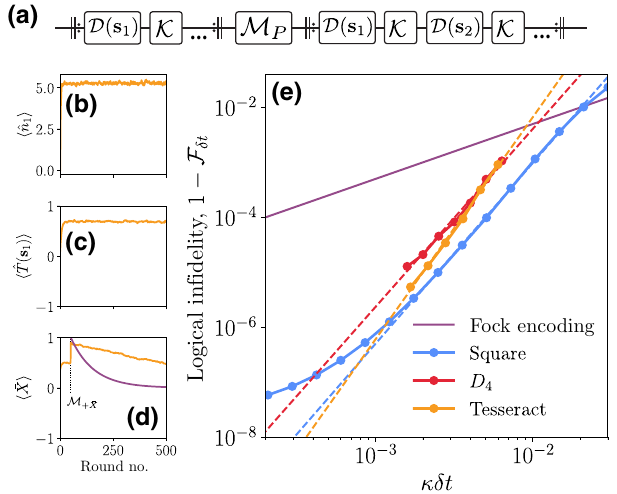
FIG. 5. Logical channel infidelity in the presence of amplitude damping. (a) Logical circuit used to extract lifetimes. The dissi- pation circuits are applied in series to project the modes into the code space, a logical measurement is performed to prepare a spe- cific Pauli eigenstate, and the dissipation circuits are applied in series to stabilize the code space. (b) Average excitation number in the first mode as a function of time, reported as the number of dissipation rounds. (c) Expectation value of the stabilizer ˆ T ( s 1 ) as a function of time. (c) Expectation value of the logical Pauli operator ¯ X as a function of time. For reference, we show the decay of the ¯ X logical operator in the Fock encoding (purple), which decays at a rate κ/ 2. Panels (b)–(d) are computed using an amplitude damping rate of κδ t = 4.6 × 10 − 3 . (e) Infidelity as a function of the amplitude damping rate κδ t for different codes. Dots are computed from simulations and dashed lines correspond to an exponential